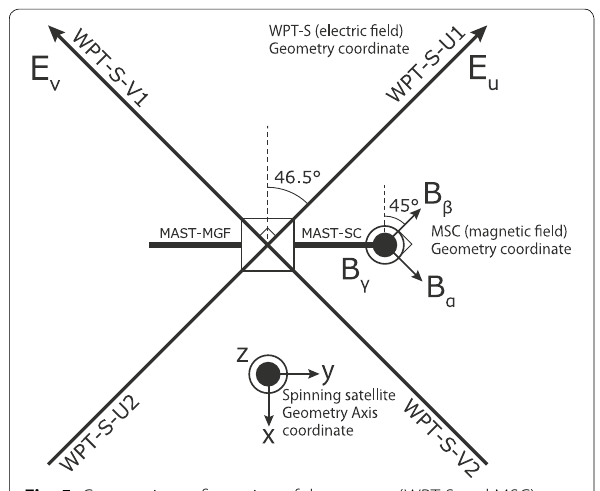
Fig. 5 Geometric configuration of the sensors (WPT-S and MSC)